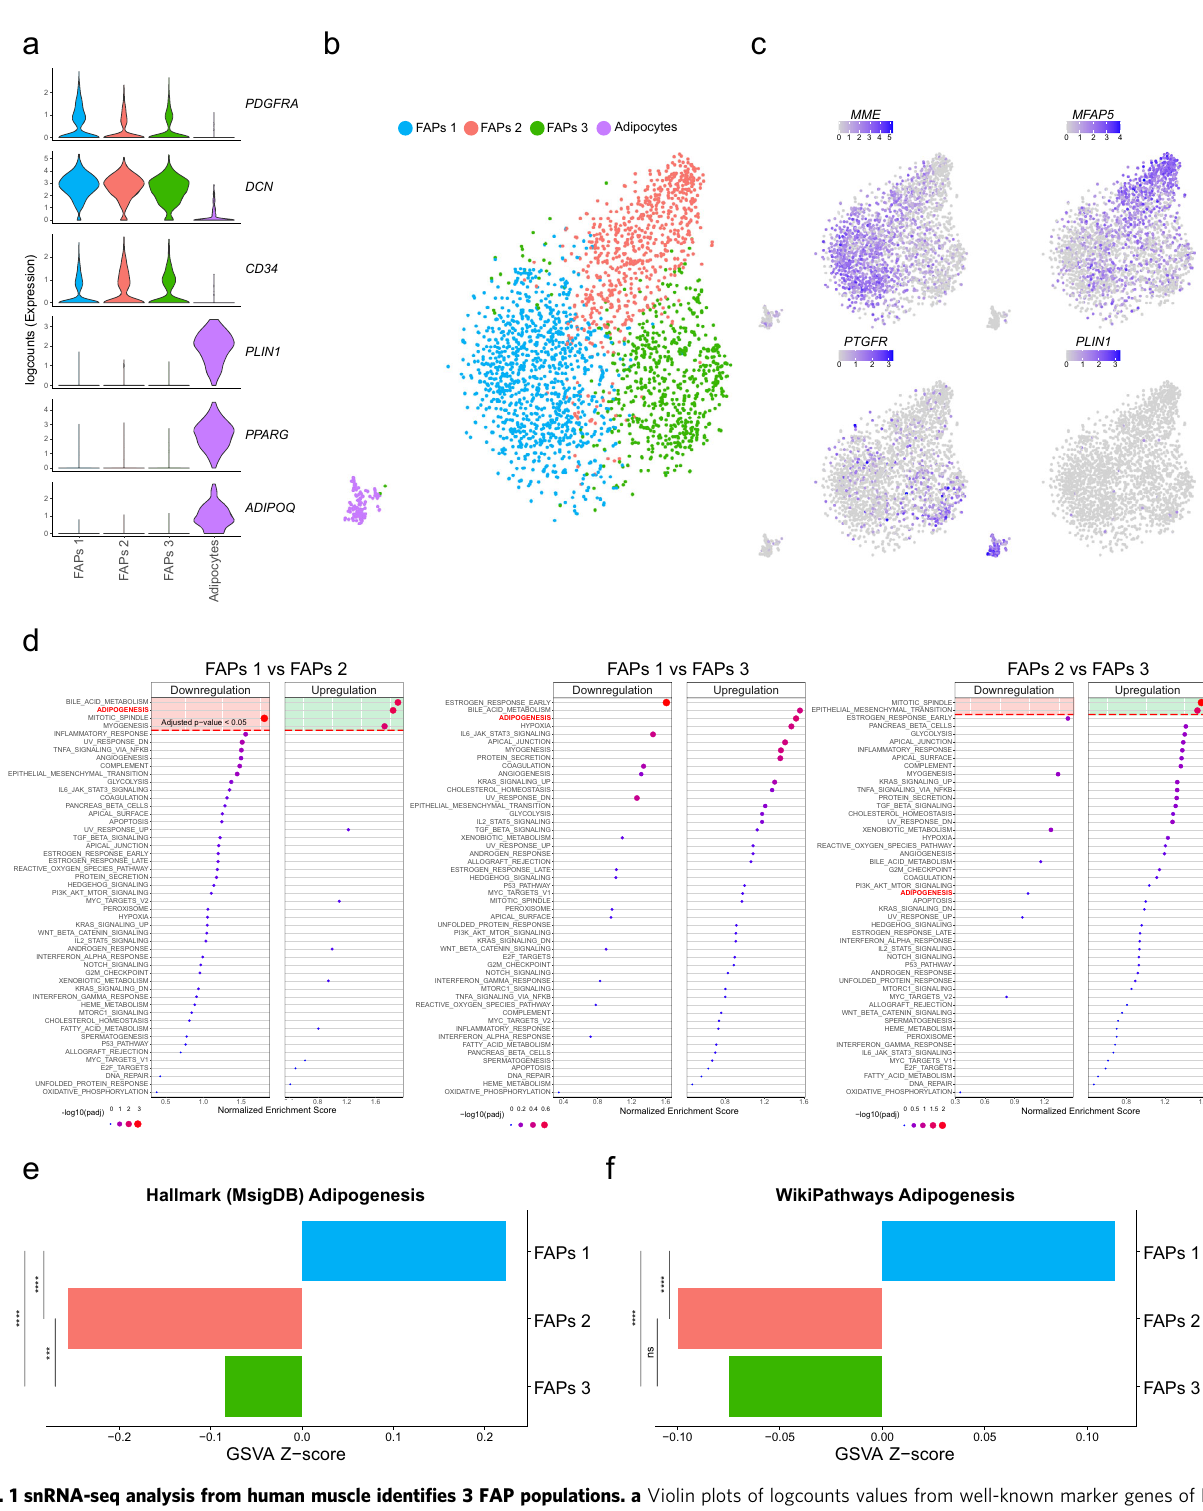
Fig. 1 snRNA-seq analysis from human muscle identi fi es 3 FAP populations. a Violin plots of logcounts values from well-known marker genes of FAPs ( PDGFRA , DCN and CD34 ) and adipocytes ( PLIN1 , PPARG and ADIPOQ ), color-coded by the identi fi ed subpopulations. b TSNE plot of FAP and adipocyte populations from human muscle, color-coded by the identi fi ed subpopulations. c TSNE plots of expression levels of marker genes from the different subpopulations, color-coded by logcounts values. d Dot plots showing upregulated or downregulated pathways from GSEA of FAPs 1 vs FAPs 2 (left panel), FAPs 1 vs FAPs 3 (middle panel) or FAPs 2 vs FAPs 3 (right panel). X-axis indicates the normalized enrichment score (NES) for each pathway. Color and size of the dots indicate adjusted p -values (FDR). Signi fi cant values are delimited by the red dashed line (Adjusted p < 0.05 or -log 10 (adjusted p -value) >1.3). e , f Bar plots showing average Z-score of GSVA of adipogenesis pathways from Hallmark (MsigDB) ( e ) and WikiPathways databases ( f ). Color- coded by identi fi ed FAPs subpopulations. *** p < = 0.001, **** p < =